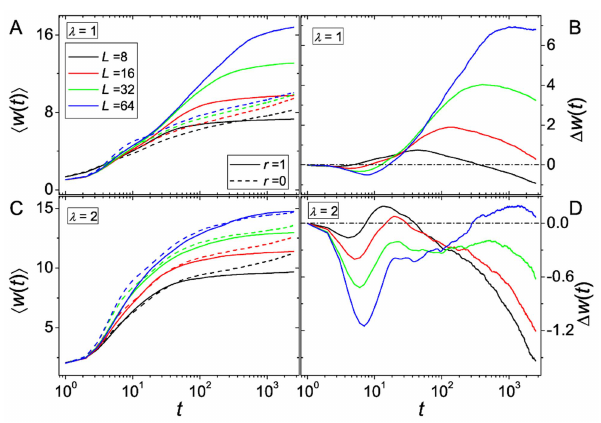
Figure 7. Recombinational advantage as a function of the number of loci. The figure shows time series of S w T and D w , respectively, for different values of the number of loci L . For l ~ 1 see (A) and (B), for l ~ 2 see (C) and (D). The population size is N ~ 2000 and the mutation rate is m ~ 0 : 002 .